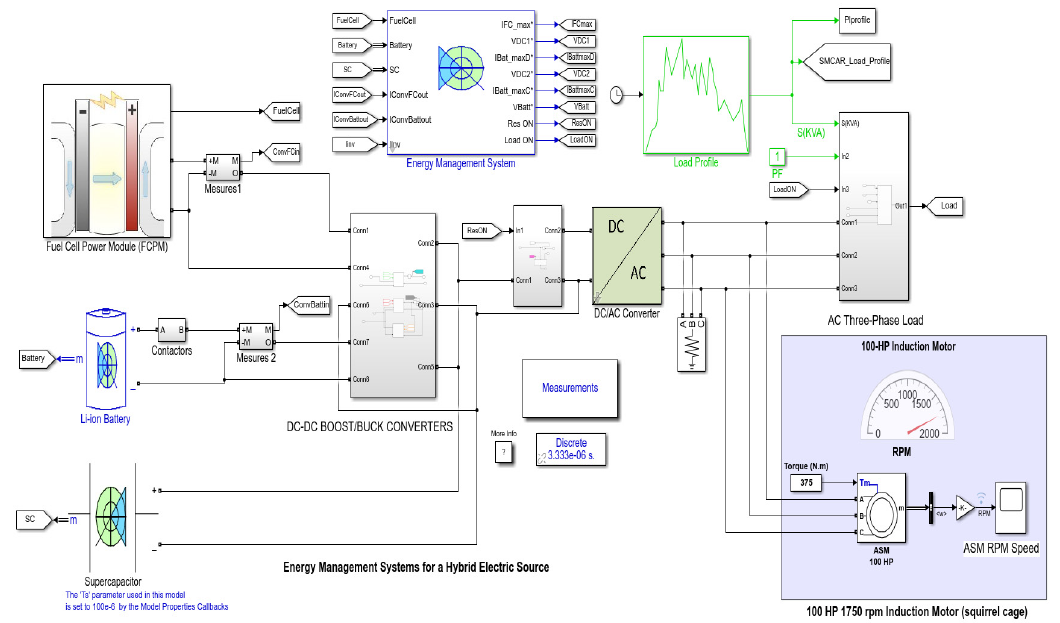
Figure 28. The 100 HP, 1750 RPM speed asynchronous induction motor (squirrel cage) connected to the output of a direct current/alternating current (DC/AC) converter (inverter).